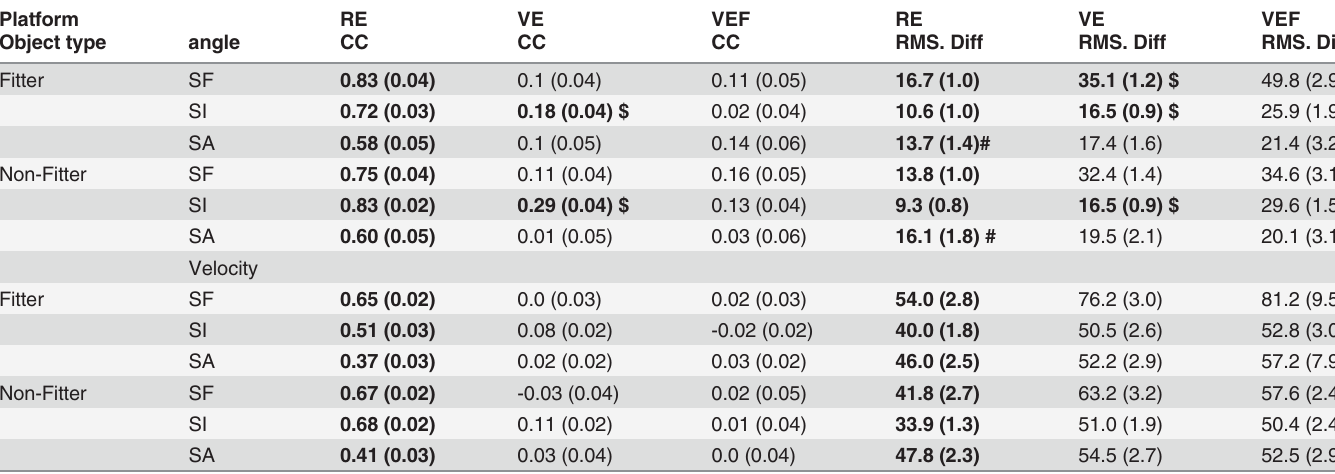
RE, VE and VEF represent “ Real ” , ‘’ Virtual ” and “ Virtual with force feedback ” platforms, respectively and “ fi tter ” and “ non- fi tter ” determine the object type. The CC and RMS. Diff within RE represent the mean of CC and RMS.Diff, the angular trajectories and velocity pro fi les for an arbitrary participant ( S i ) and a representative trajectory, i.e., the median of traces across all subjects ( S (cid:1) ). Thus, CC and RMS. Diff within RE indicate CC or RMS.Diff ( RE S Whereas CC and RMS. Diff within VE and VEF were between the kinematic trajectories in virtual and virtual with force feedback platforms on one hand and their corresponding trajectories within the real platform on the other hand, i.e., CC or RMS.Diff ( RE S respectively. The bold fonts in RE columns indicate signi fi cant difference between RE and both VE and VEF. # indicates that this difference was signi fi cant only between RE and VEF. $ indicates a signi fi cant difference between VE and